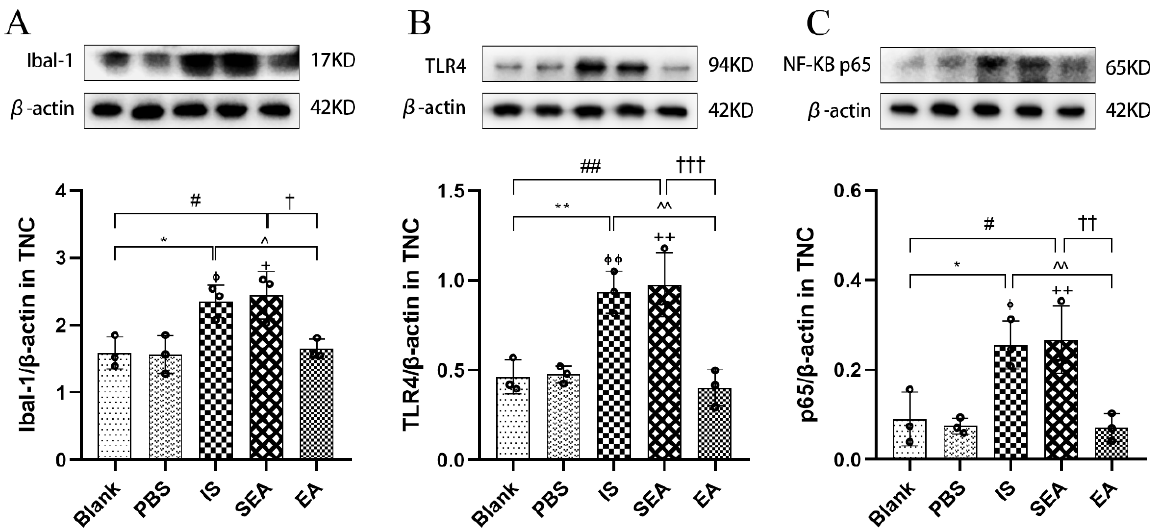
Figure 6. Ibal ‐ 1, TLR4, and NF ‐κ B protein expression levels in TNC assessed by Western blot assay in five groups of rats ( n = 3/group). Repeated IS infusions into dura induced an increased protein expression of Ibal ‐ 1, TLR4, and NF ‐κ B, while EA decreased protein expression of the above factors. ( A ) Ibal ‐ 1 protein expression levels. ( B ) TLR4 protein expression levels. ( C ) NF ‐κ B protein expression levels. Protein expressions levels were normalised against β‐ actin and analysed using ANOVA and Tukey’s post hoc analysis test, and densitometry results are shown as the mean ± standard deviation. * p < 0.05, ** p < 0.01, Blank vs. IS; ⏀ p < 0.05, ⏀⏀ p < 0.01, PBS vs. IS; # p < 0.05, ## p <